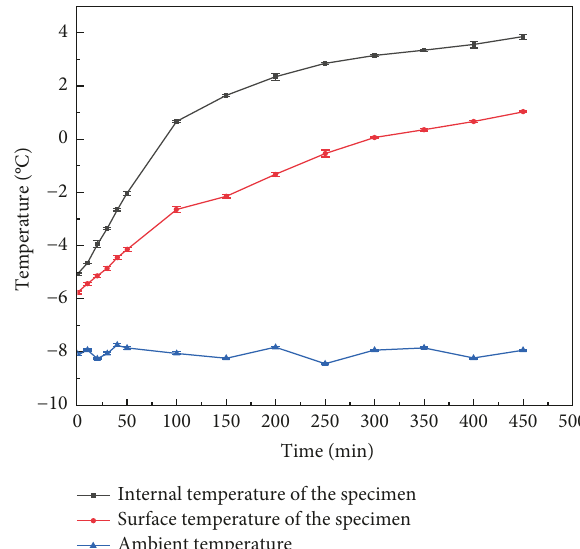
Figure 17: Deicing effect of 0.4% carbon fiber +30% graphite rutting plate.